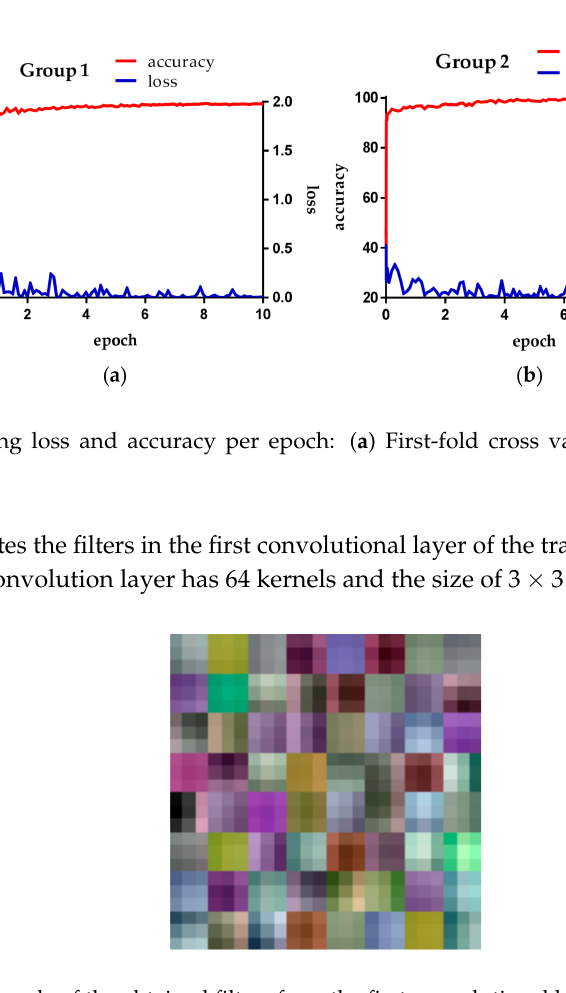
Figure 6. Example of the obtained filters from the first convolutional layer through training.